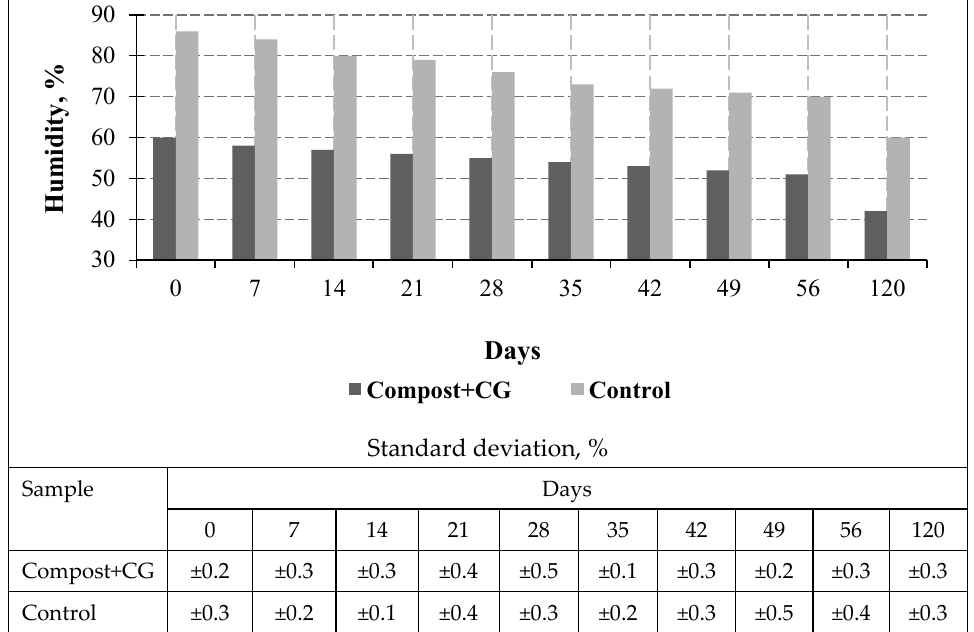
Figure 4. Changes in moisture content during composting.